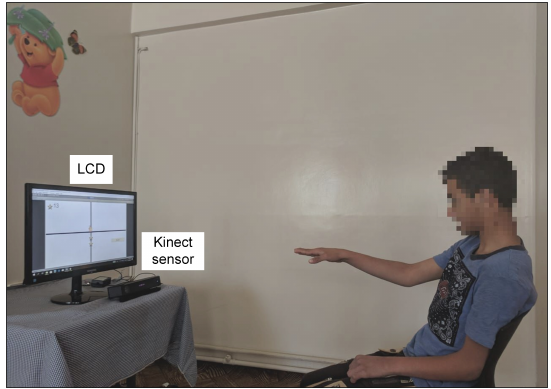
Figure 1. A cerebral palsy patient playing one of the game-based rehabilitation exercises provided by our proposed